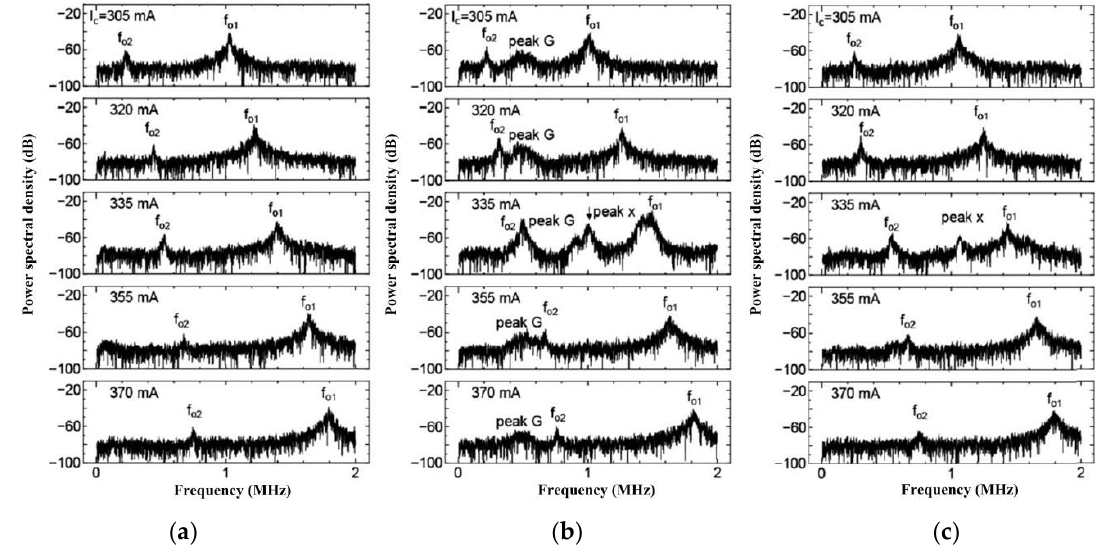
Figure 11. ( a ) Power spectra of the laser output observed when the laser light is emitted into the atmosphere. Power spectra of the modulated wave observed in drained ( b ) 7 × 10 −3 wt% and ( c ) 7 × 10 −5 wt% PLS-water mixture with PLS 250 nm in diameter. (Figure reproduced from Ref. [64]).